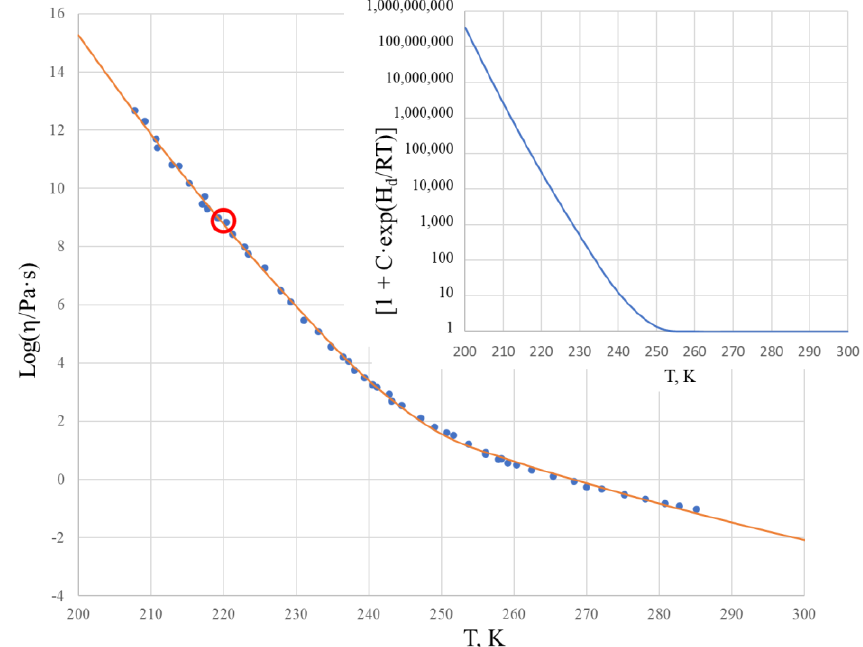
Figure 4. The viscosity of vitreous and molten α-phenyl- o -cresol using the two Sheffield equations (Equations (1) and (2)). Experimental data were taken from [33], with the red circle indicating T g = 220 K [33]. The inset shows the temperature dependence of factor [1 + C · exp(H d / RT)] in Equations (1) and